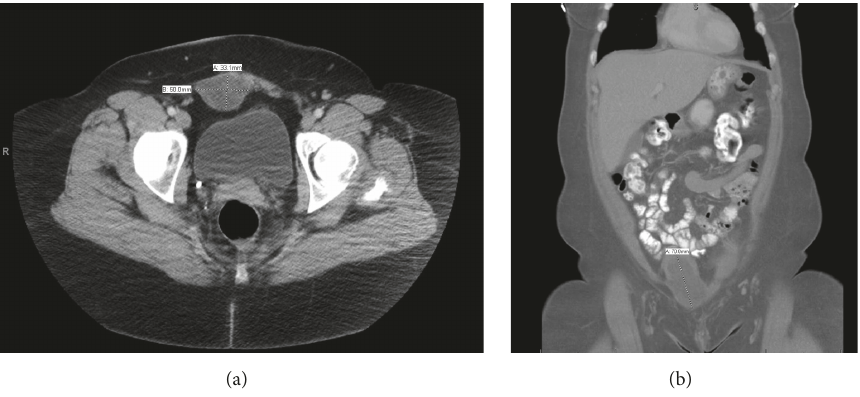
Figure 1: CT image of the abdominal mass shows a right lower rectus muscle heterogeneous collection: axial (a) and coronal (b)